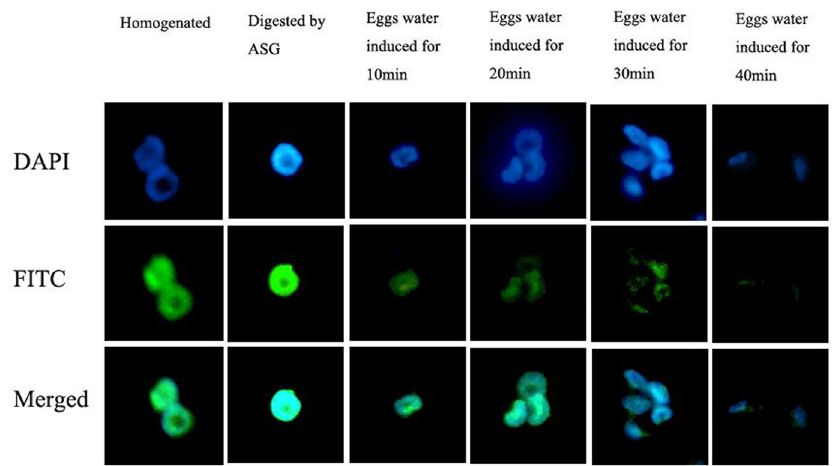
Fig 4. Changes in immunofluorescence staining patterns of antibodies against human Es-serpin in E . sinensis sperm during the acrosome reaction. Sperm were incubated in eggs water for 40min, and the reaction was terminated by 4% paraformaldehyde respectively at 10min, 20min, 30min,